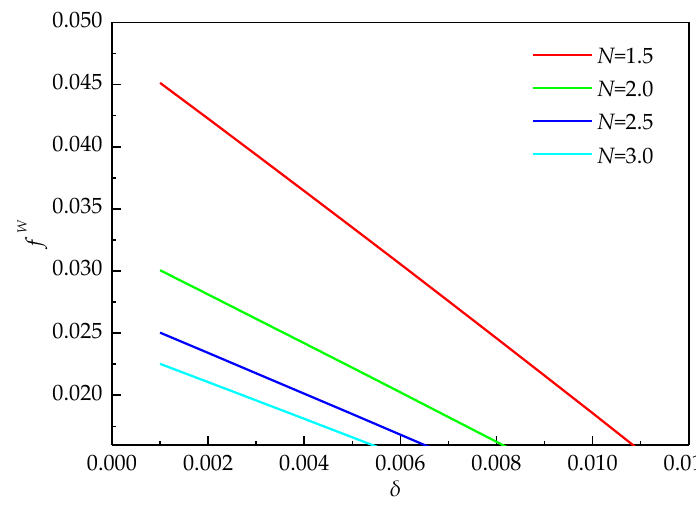
Figure 5. The relationship between f W and δ .